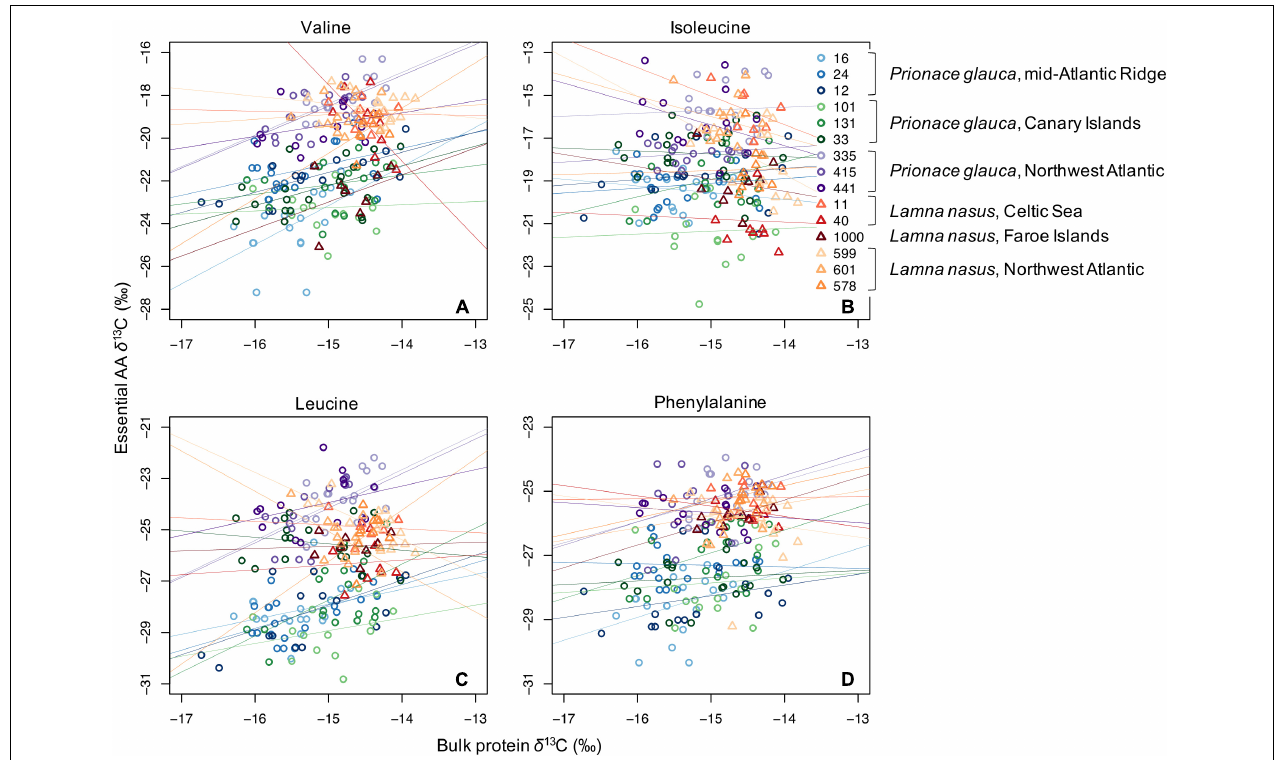
FIGURE 3 | Scatterplots of raw δ 13 C values of bulk protein vs. single essential amino acids ( A , valine; B , isoleucine; C , leucine; and D , phenylalanine) in comparable vertebral samples from individual blue sharks and porbeagles caught across the North Atlantic (as in figure legend).